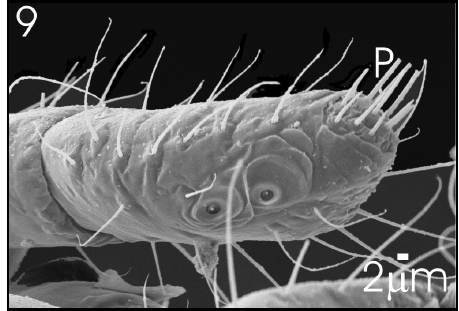
Fig. 9. The sensory equipment on the last segment of Damalinia crenelata showed that the sensilla basoconica comprised 10 pegs.